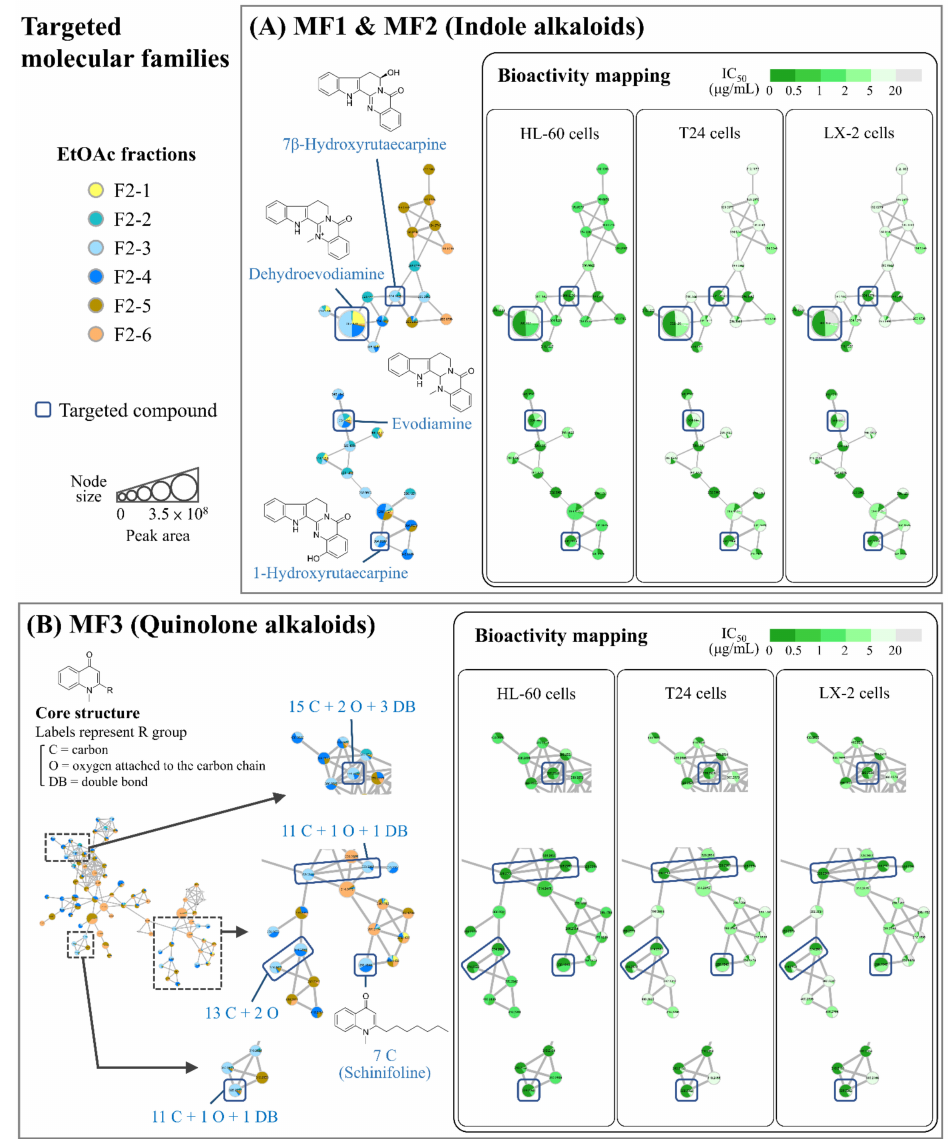
Figure 2. Prioritization of the potentially antiproliferative compounds in T. ruticarpum fruit using multi-informative molecular networking: ( A ) Targeted molecular families containing indole alkaloids. ( B ) Targeted molecular family containing quinolone alkaloids. Values in the nodes are precursor m / z . The node size is proportional to the sum of the chromatographic peak area. The edge width is proportional to the MS/MS spectral similarity between two connected molecules. MF: Molecular family. IC 50 : Half maximal inhibitory